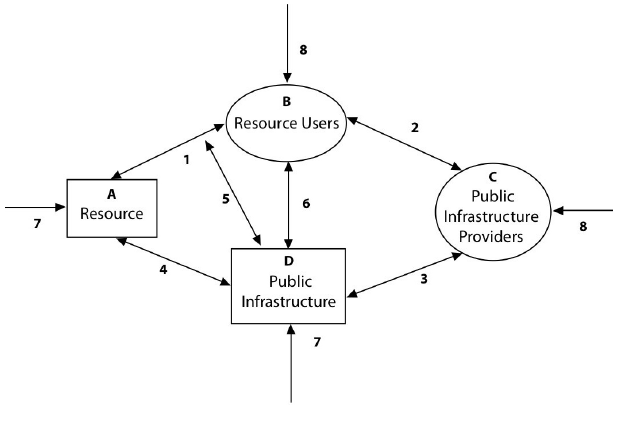
and the public infrastructure providers (C). Arrow numbers in the figure signify interaction as follows: (1) between resource and resource users; (2) between users and public infrastructure providers; (3) between infrastructure providers and public infrastructure; (4) between public infrastructure and resource; (5) between public infrastructure and resource dynamics; (6) between resource users and public infrastructure; (7) external forces on resource and infrastructure; (8) external forces on social actors. Source: Anderies et al. 2004.